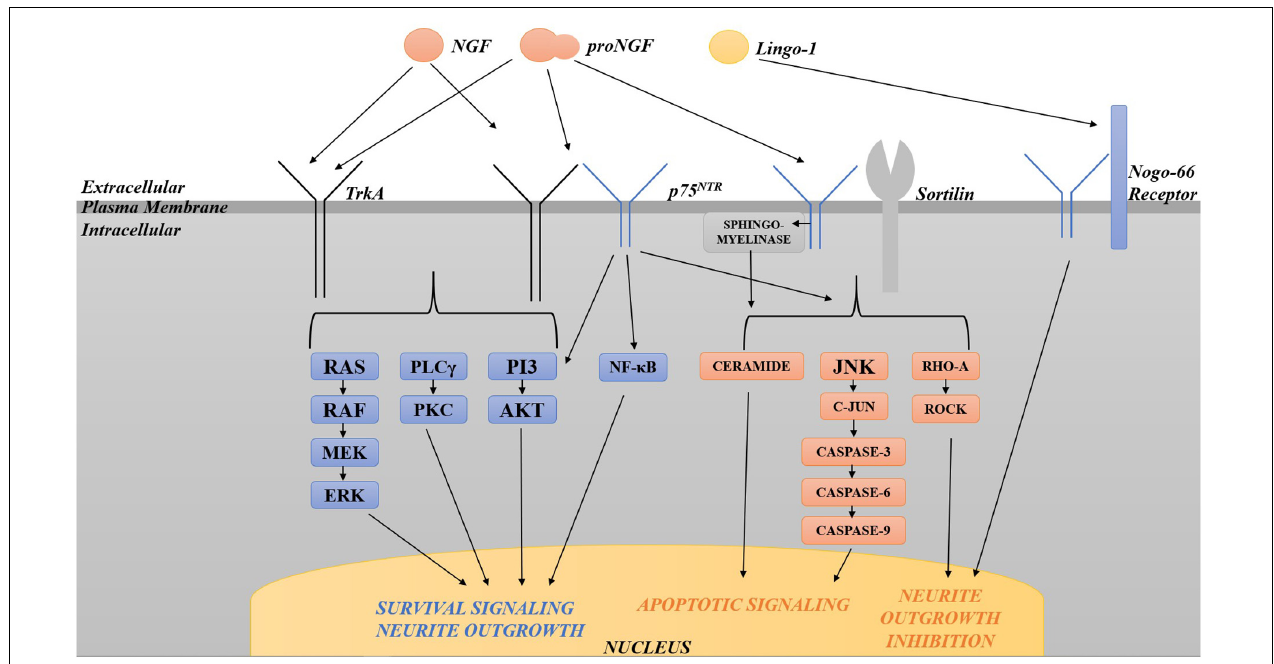
FIGURE 2 | Diagram of the various pathways activated by TrkA and p75 NTR . TrkA in isolation activates pro-survival pathways including the Ras-MAP kinase, PLC γ , and PI3 kinase/Akt pathways. p75 NTR , when complexed with TrkA, increases pro-survival signaling through TrkA. p75 NTR in isolation can also signal survival via the NF- κ B and PI3/Akt pathways. p75 NTR in isolation activates apoptosis via sphingomyelinase/ceramide, JNK, c-Jun phosphorylation and caspases 3, 6, and 9. When complexed with sortilin, p75 NTR binds proNGF with a higher affinity than NGF, signaling cell death through the same pathways. p75 NTR can also cause growth cone retraction/neurite outgrowth inhibition when complexed with the Nogo-66 receptor and its ligand Lingo-1. The balance of Trks and p75 NTR is crucial to the functional outcome of neurotrophin